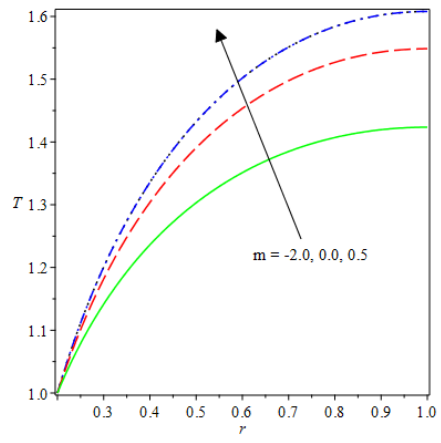
Figure 8. Temperature profile for increasing ( λ ) .